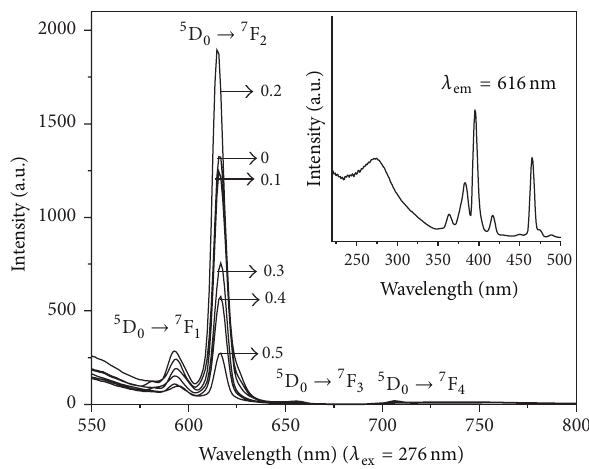
Figure 4: Emission spectra of (Ca 1−𝑥 , La 𝑥 )MoO 4 :0.05Eu 3+ ( 𝑥 = 0.1 , 0.2, 0.3, 0.4, and 0.5) phosphors ( 𝜆 spectrum of (Ca 0.8 , La 0.2 )MoO 4 :0.05Eu 3+ phosphor 𝜆 (inset).